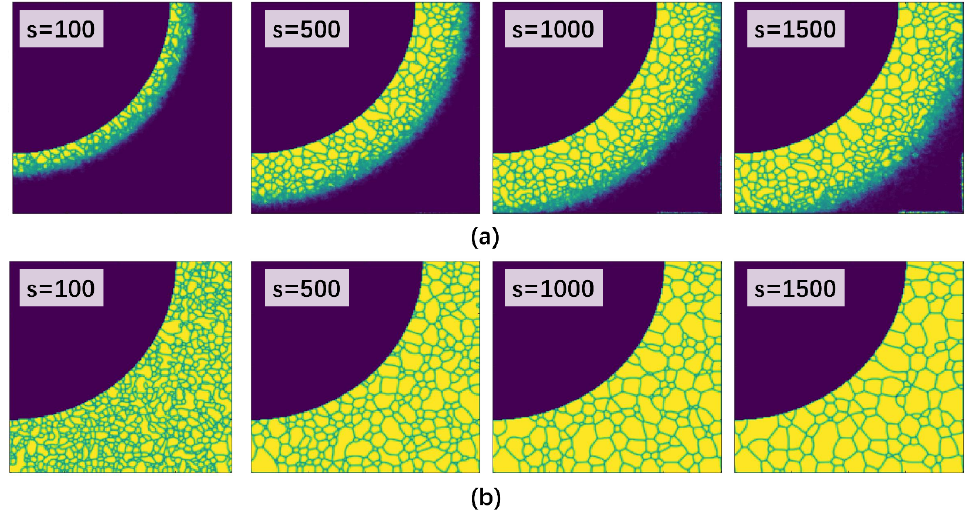
Figure 6. Computed evolution of grain structures in the HAZ of ( a ) low-carbon steel and ( b ) Fe–6.5 wt.% Si alloy in the cross section perpendicular to the direction of welding.